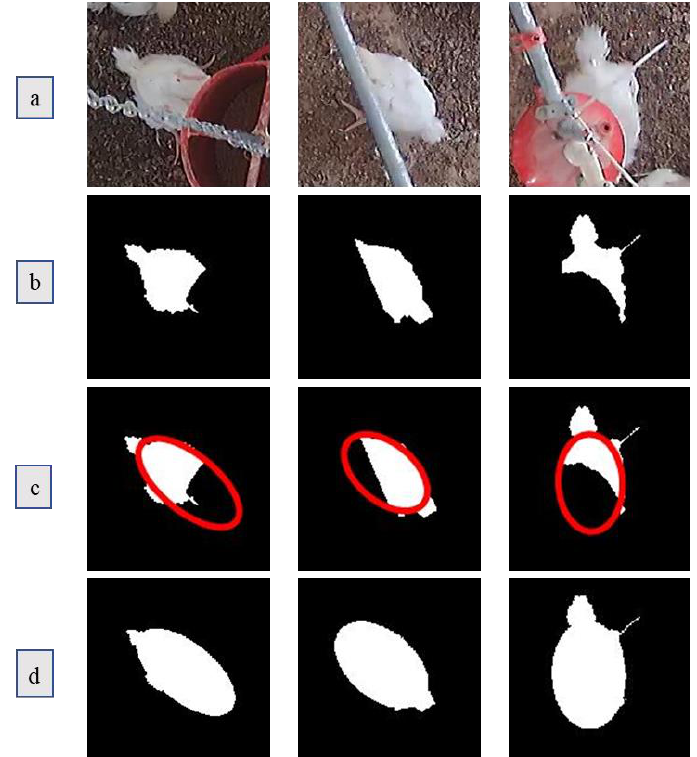
Figure 7. Example of the occlusion area restoration for OA: ( a ) is the original occlusion image; ( b ) is the corresponding detected binary image; ( c ) is the corresponding fitted ellipse (the red ellipse); and ( d ) is the restored result.